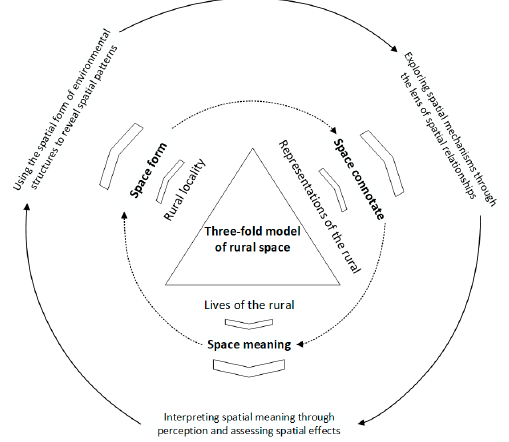
Figure 2. The three-fold model of rural space.